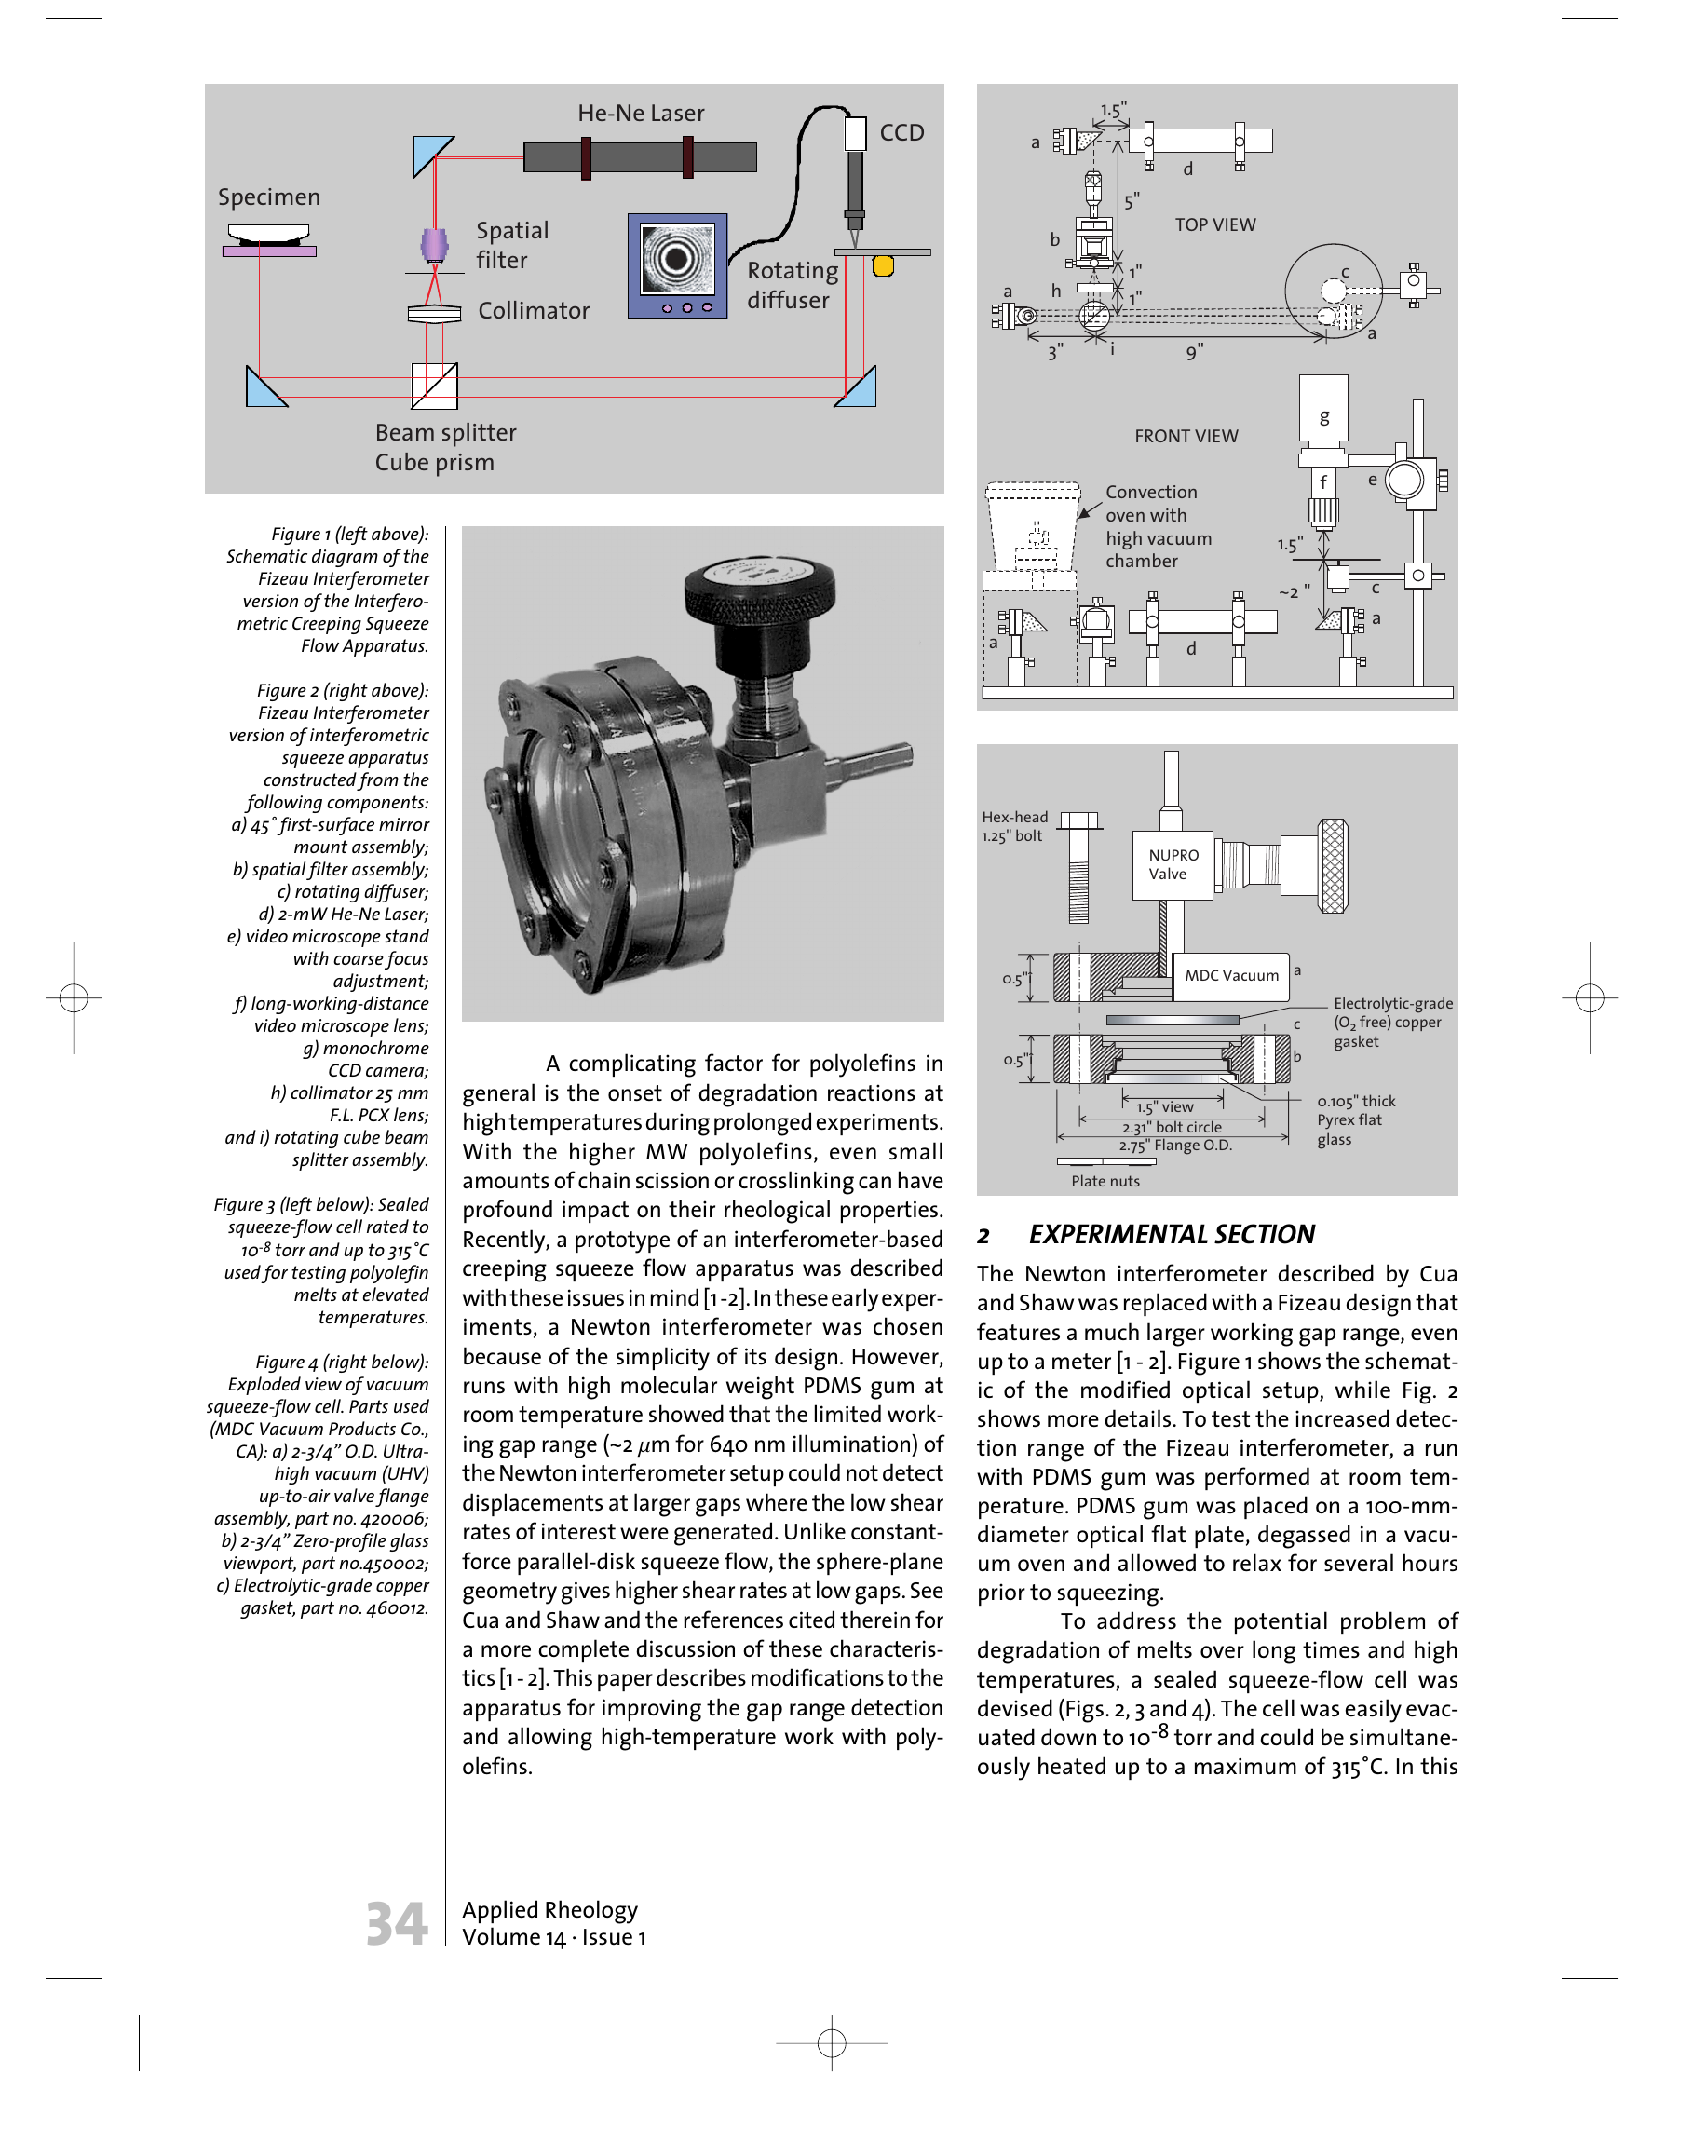
Figure 3 (left below): Sealed squeeze-flow cell rated to 10 -8 torr and up to 315˚C used for testing polyolefin melts at elevated temperatures. Figure 4 (right below): Exploded view of vacuum squeeze-flow cell. Parts used (MDC Vacuum Products